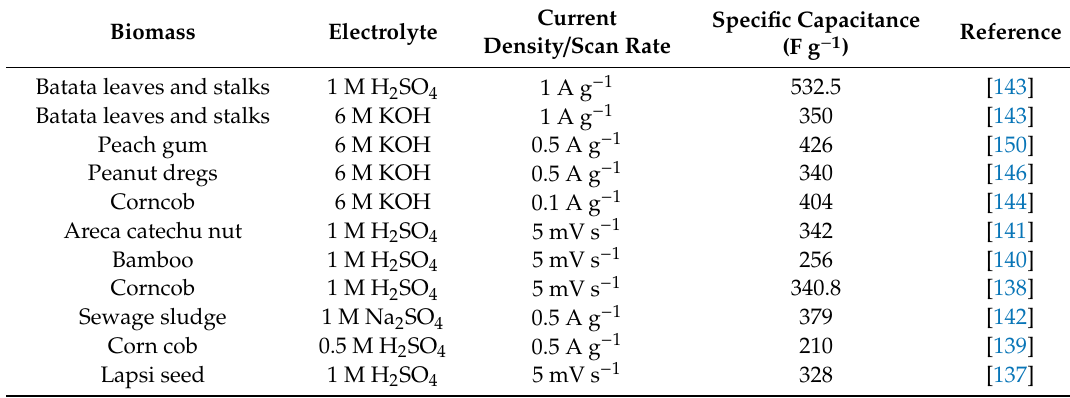
Table 1. Electrochemical supercapacitance performance of biomass-derived various nanoporous carbon